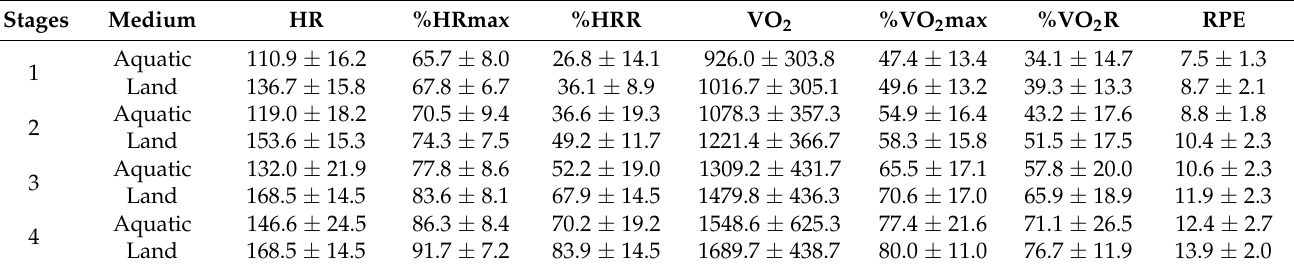
Table 3. Descriptive statistics (mean ± SD) for HR, %HRmax, %HRR, VO 2 , %VO 2 max, %VO 2 R, and RPE at each stage of the aquatic and land incremental tests.